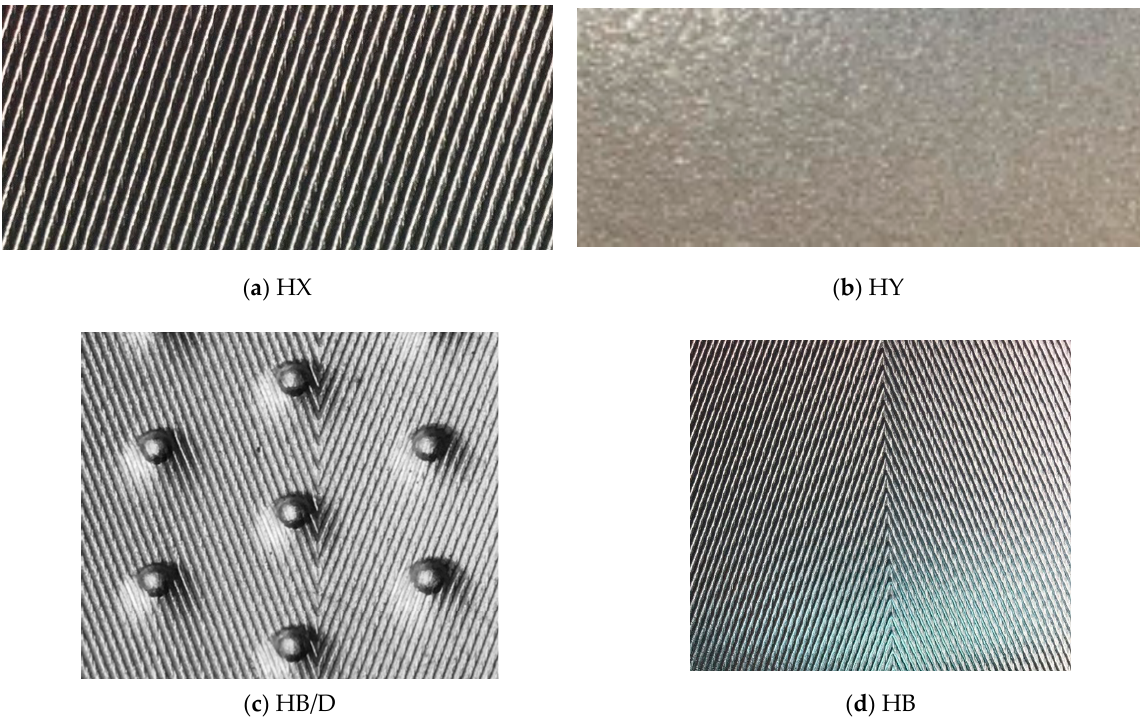
Figure 2. Surface parameters of the enhancement pattern for the ( a ) HY tube, ( b ) HB tube, ( c ) HB/D tube, and ( d ) HX tube. Table 1. Physical measurements of the enhancement patterns used in the various tubes.